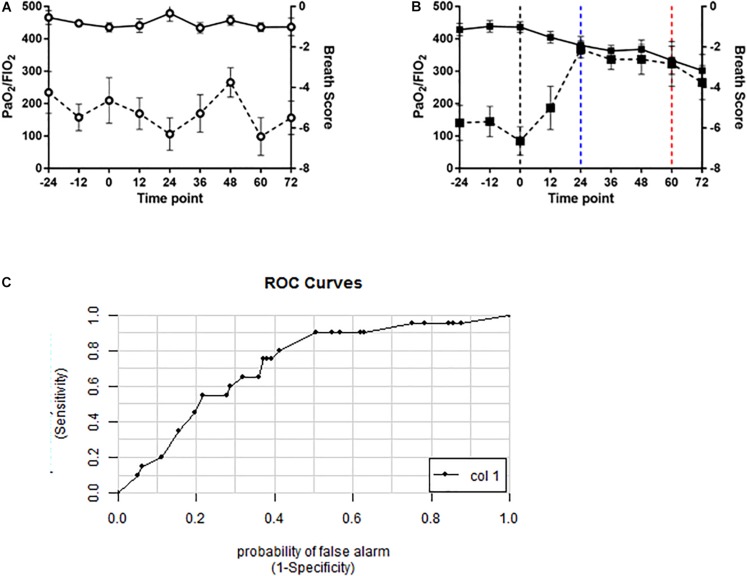
Volatile organic compound based breath score predicts decrements in PaO2/FiO2 ratio in oxygen-exposed swine. Line graphs depicting breath score (dashed line) and PaO2/FiO2 ratio (solid line) in (A) air controls (open circles) and (B) oxygen exposed (closed squares) swine. Vertical black dashed line indicating randomization timepoint. Vertical blue dashed line indicated significantly increased breath score. Vertical red dashed line indicates the P/F ratio < 350 mmHg. Breath scores were significantly increased from baseline in oxygen-exposed but not air controls (p < 0.0001, repeated measures ANOVA). (C) ROC curve for the breath score predicting a PaO2/FiO2 ratio of < 350mmHg. The area under the curve is 0.72 indicating a 72% probability that the breath score will predict oxygen toxicity as defined by a PaO2/FiO2 ratio of 350 mmHg or less.